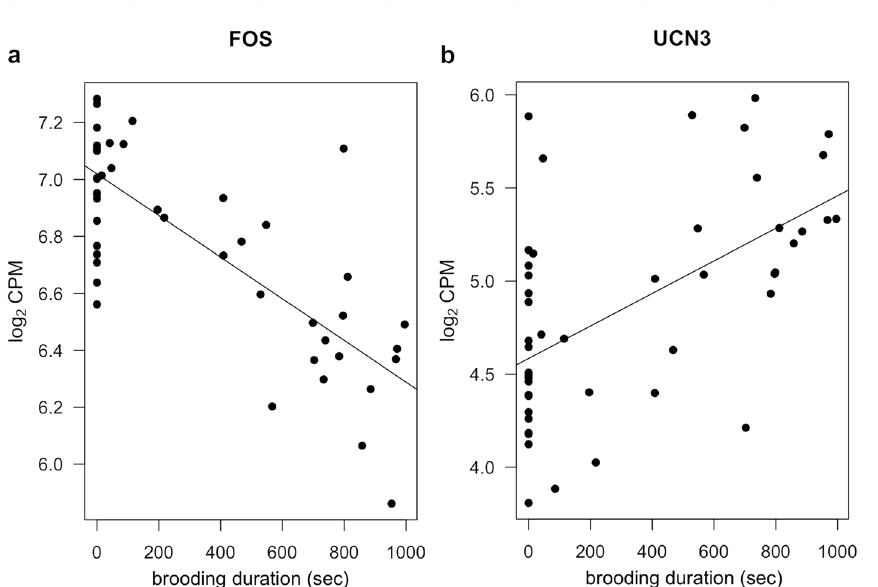
Figure 3. Regression lines representing the relationship between brooding duration (seconds) and FOS expression ( a ) or UCN3 expression ( b ). Statistical details for all genes that covary with brooding duration can be found in Supplementary Table